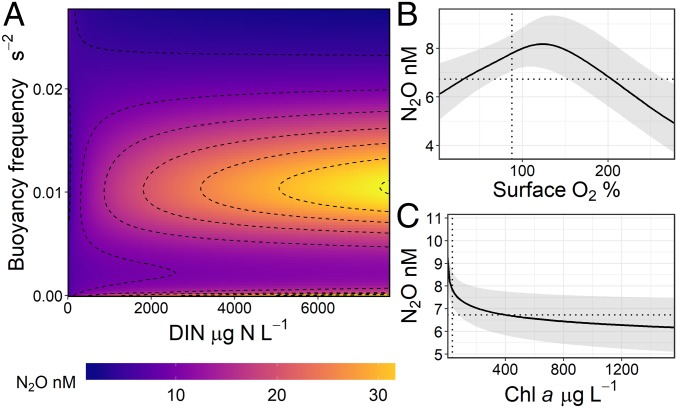
GAM model illustrating partial effect plots for N2O concentrations (nM) with significant environmental variables for the agricultural reservoirs. Responses are best explained by (A) the interaction between buoyancy frequency and dissolved inorganic nitrogen (DIN), (B) surface O2, and (C) Chl-a concentrations. Shaded area in B and C indicates 95% credible intervals, while dotted lines represent medians of the predictor and response variables. Deviance explained by the model was 85%. Complete statistics can be found in SI Appendix, Table S2.